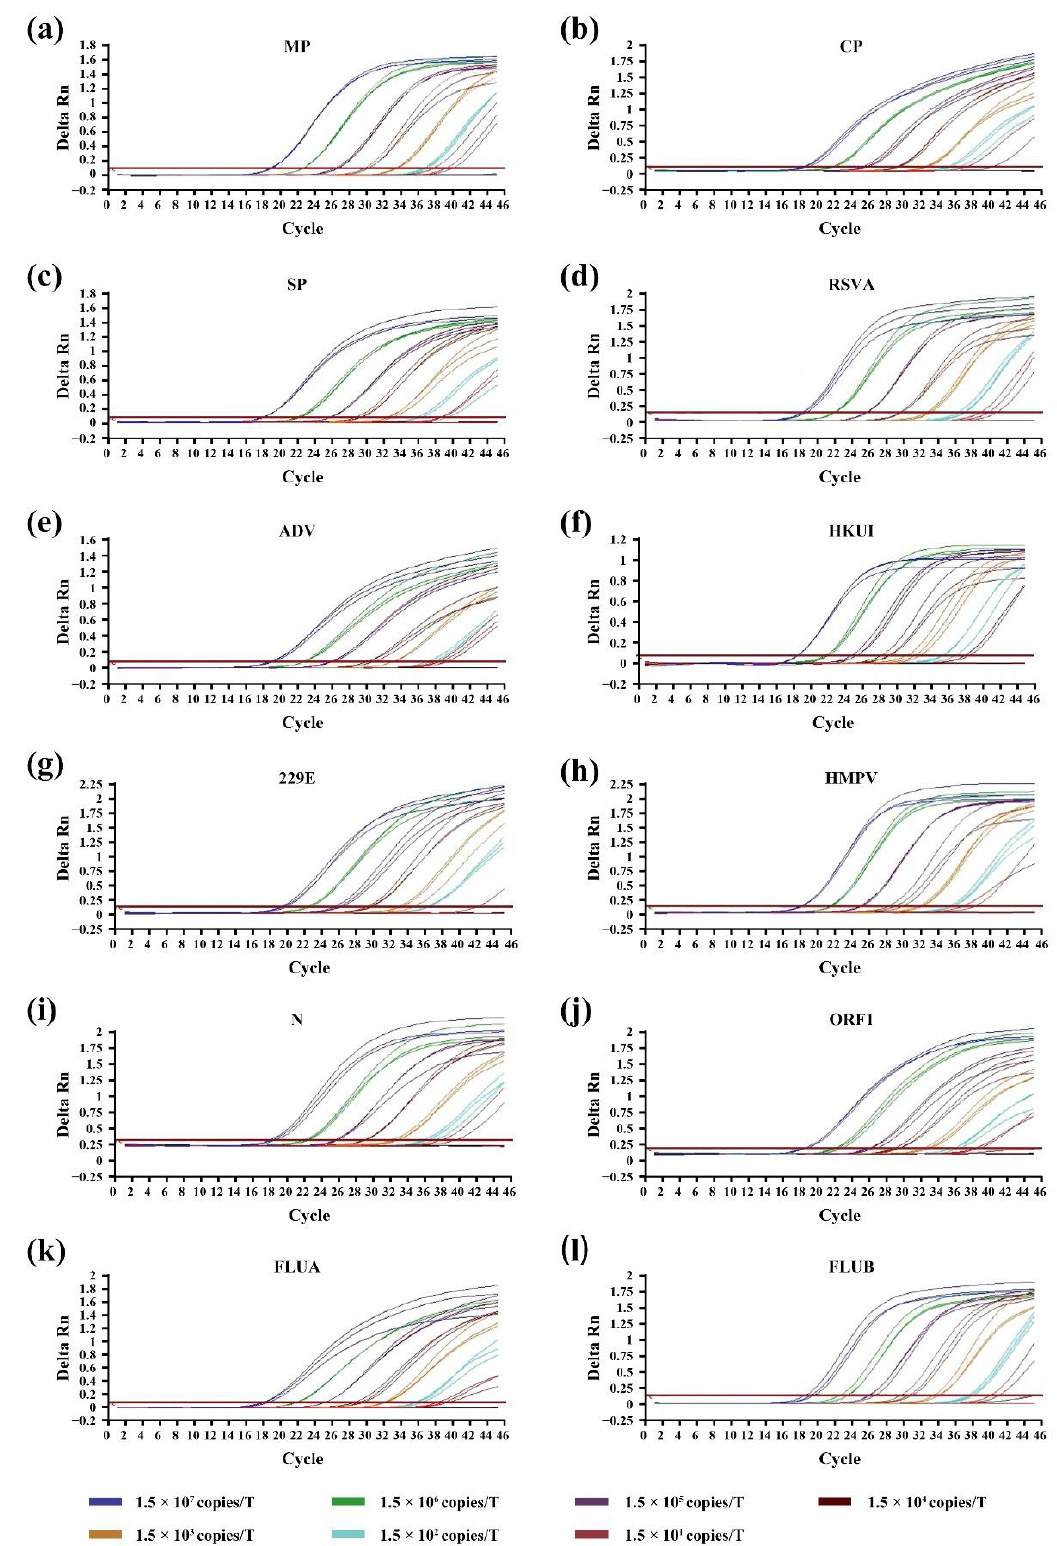
Figure 3. The sensitivity of the microfluidic RT-qPCR assays off-chip. Amplification curves show the detection of pathogens plasmids of ( a ) MP, ( b ) CP, ( c ) SP, ( d ) RSVA, ( e ) ADV, ( f ) HKU1, ( g ) 229E, ( h ) HMPV, ( i ) N, ( j ) ORF1, ( k ) FLUA and ( l ) FLUB.